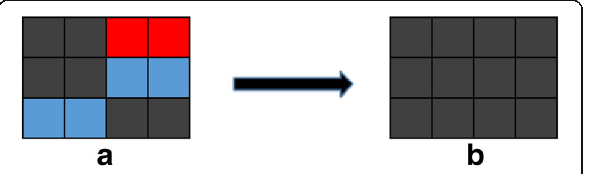
Fig. 2 The diagram of PolSAR image classification based on SVM classification and the majority voting principle. Different colors represent the labels of pixels. a SVM classification result in a superpixel. b Classification result after majority